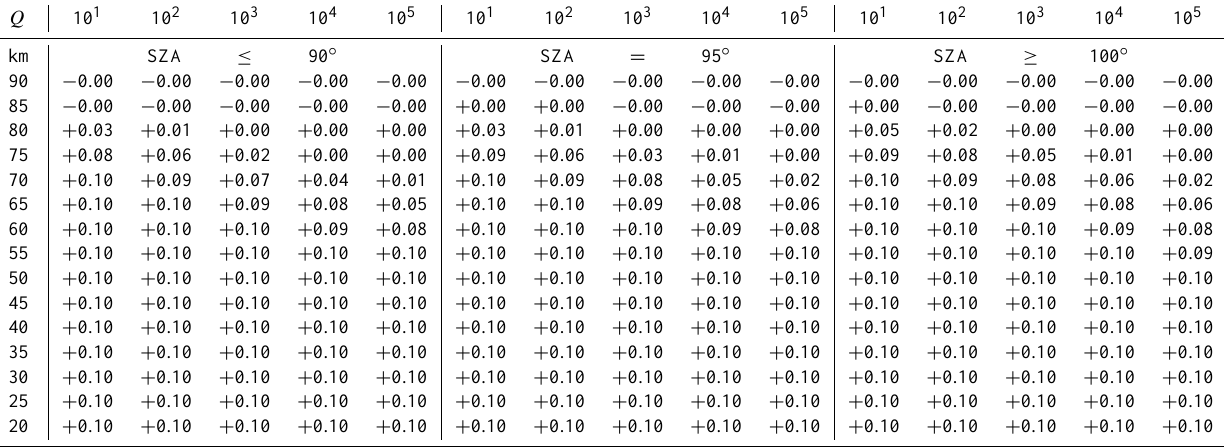
/Q for October SH. 2